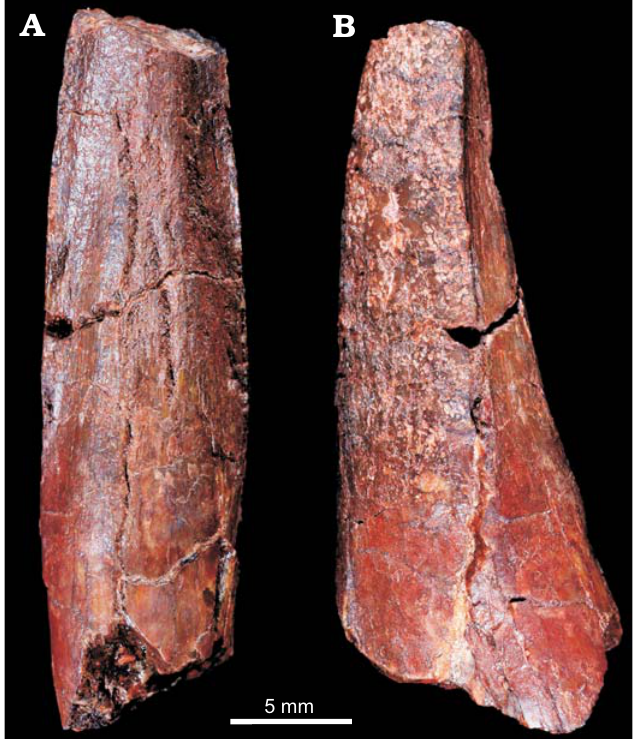
Fig. 9. Traversodontidae indet. (cf. Exaeretodon sp.) from Sacisaurus site, Late Triassic Caturrita Formation, Agudo, Rio Grande do Sul Brazil; MCN-PV 10205, isolated left lower incisor 1 in lingual ( A ) and distal ( B )